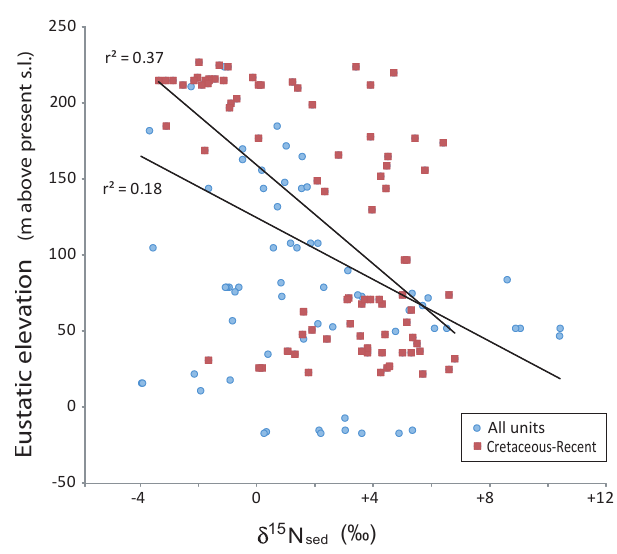
Fig. 11. δ 15 N sed versus eustatic elevation (data from Fig. 10). A significant negative relationship exists for all Phanerozoic marine units ( r 2 = 0 . 18; n = 153; p(α)< 0.05), although the relationship is distinctly stronger for Cretaceous–Recent units ( r 2 = 0 . 37, n = 84; p(α)<